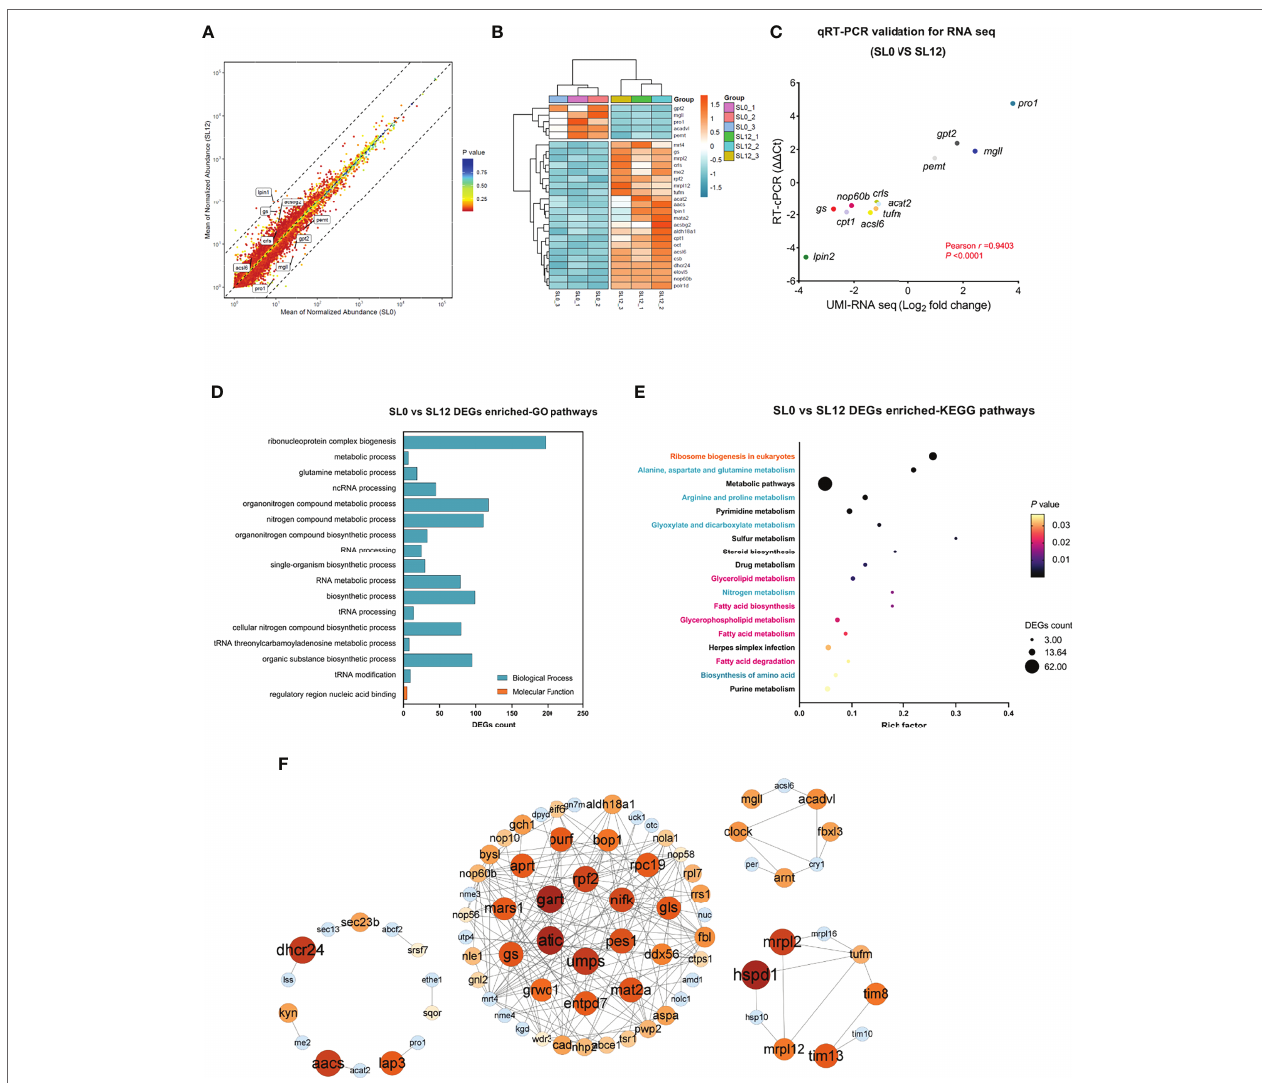
FIGURE 3 | Transcriptome analysis of larval liver tissue corresponding to dietary phospholipid levels. (A) Volcano plot of detected gene expression levels between the SL0 and SL12 groups. A total of 427 DEGs were detected. (B) Heatmap presentation for partial DEGs between treatments. The block color diversity characterizes the gene expression levels. (C) UMI-RNA-seq DEG validation by qRT–PCR. (D, E) DEG-enriched GO and KEGG pathways between groups. (F) Potential association network for predicted DEGs constructed using Cytoscape software with high